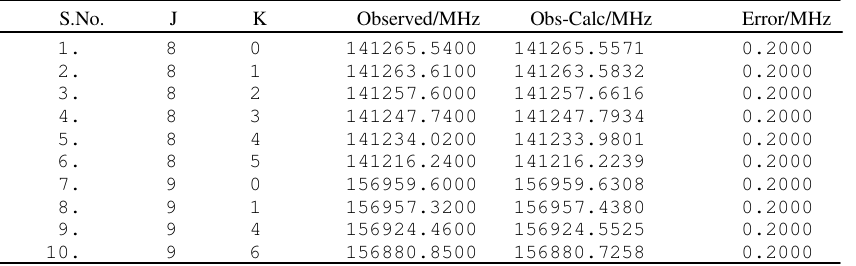
Table 13. Results of refinement of observed frequencies for CD 313 CN in the ground state 22,25 .